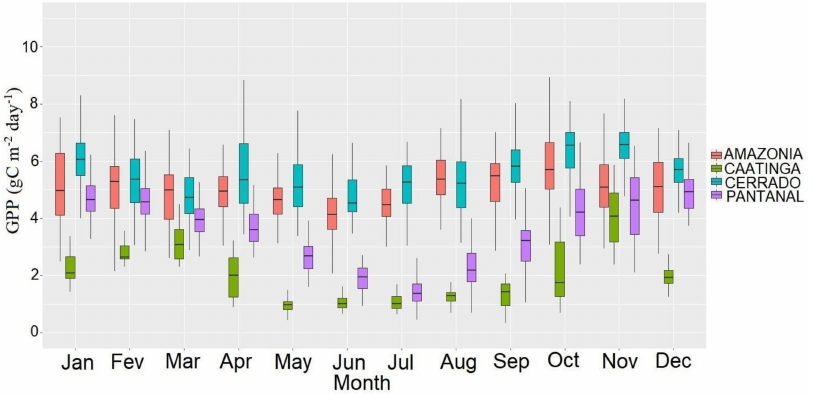
Figure 7. Monthly GPP (gC m − 2 day − 1 ) boxplot for each site and study period (Amazonia: